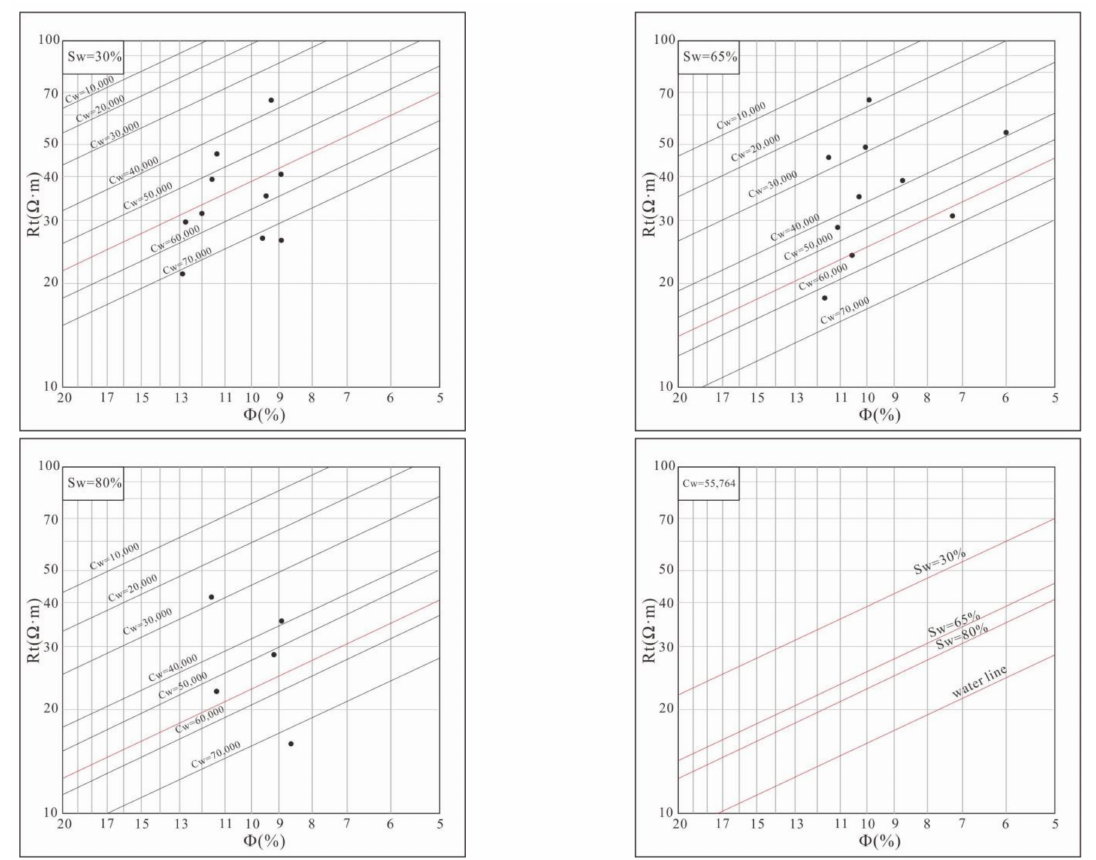
Figure 12. Method for identifying salinity fluid using a basic